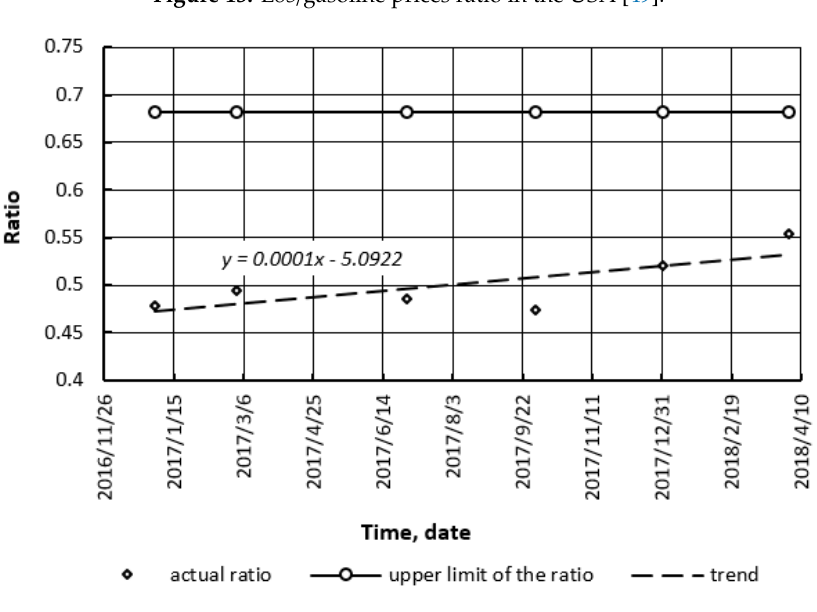
Figure 14. LPG / diesel prices ratio in